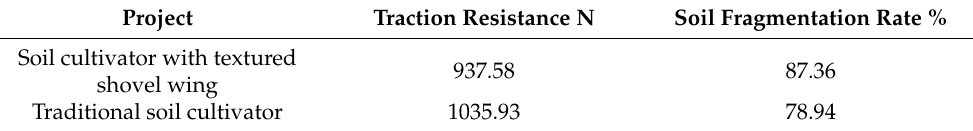
Table 5. Comparison of the traditional soil cultivator and soil cultivator with textured shovel